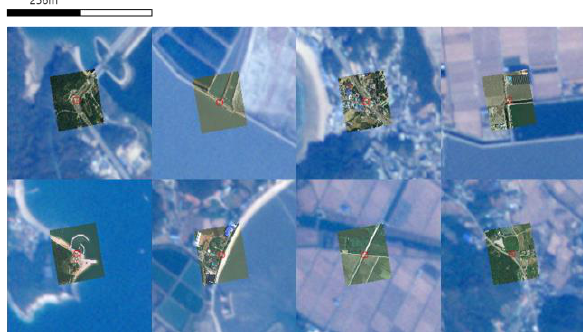
Figure 5. GCP Chips that matched as inlier.